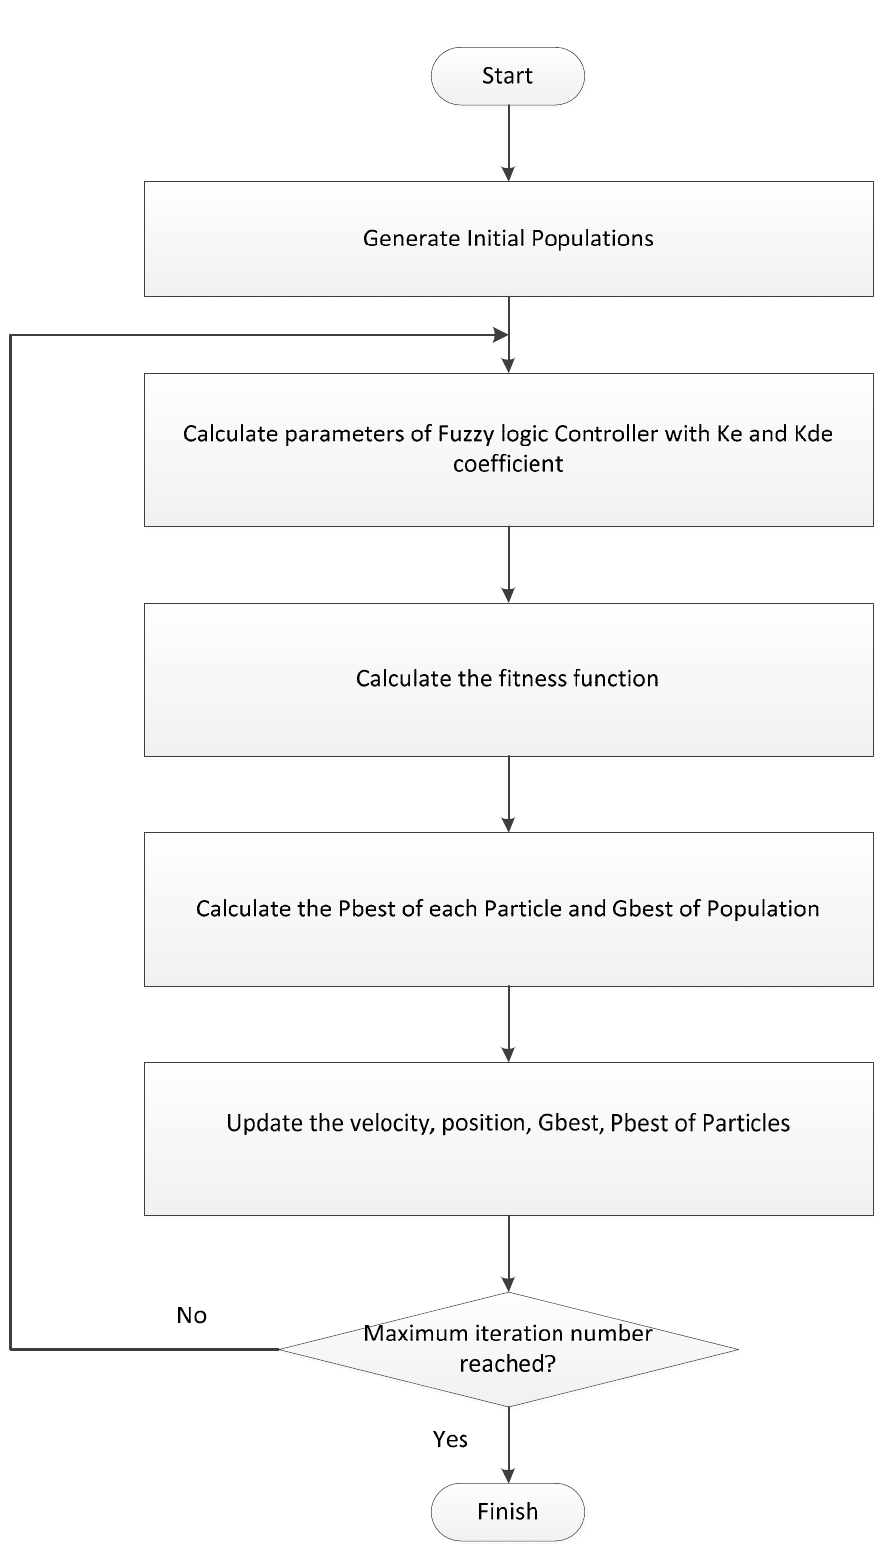
Figure 10. Algorithm of applying PSO to optimize fuzzy logic controller.